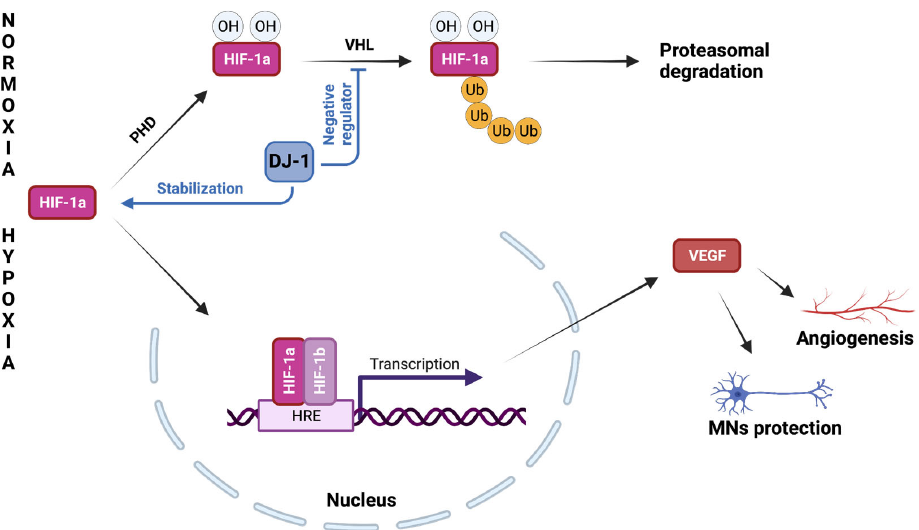
Figure 2. DJ ‐ 1 ‐ mediated protection against hypoxia. Under normoxia conditions, HIF ‐ 1 α is constantly hydroxylated, ubiquitinated, and degraded at the proteasome. Under hypoxic conditions, HIF ‐ 1 α translocates into the nucleus, where it promotes the expression of numerous genes involved in hypoxic adaptation. Among them, the VEGF protein stimulates vessel growth and promotes the survival of motor neurons during hypoxia. DJ ‐ 1 has been proposed to act as a negative regulator of VHL stabilizing the transcription factor HIF ‐ 1 α . Acronyms are mentioned in the main text. (Created with BioRender.com, accessed on 6 April 2023.)